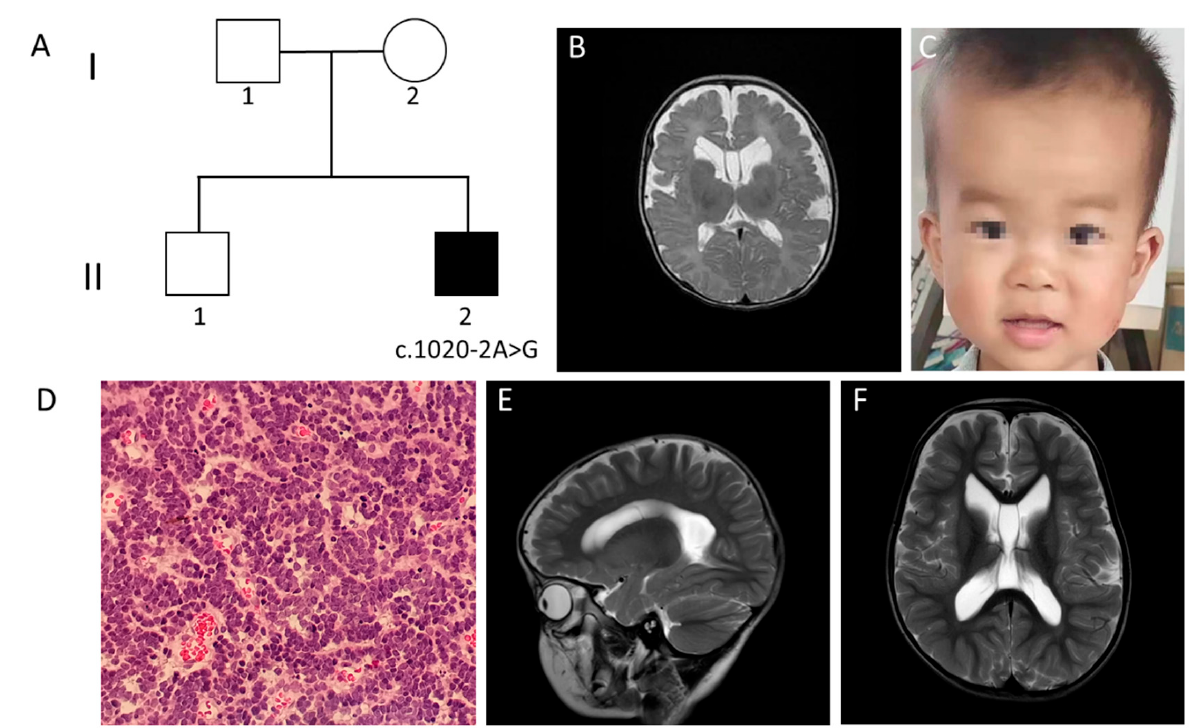
Figure 2. Clinical manifestations and auxiliary examinations of the case 2. ( A ) Family pedigree of case 2. ( B ) Brain MRI scans at 42 days demonstrated widened brain ventricle, deep brain sulci and subependymal cyst (axial plane, T2-weighted image). ( C ) Distinctive facial features were identified. These included protruding forehead, rounded palpebral fissures, large irises, depressed nasal root, full nasal tip and abnormal gums. ( D ) Hematoxylin and eosin staining of surgical resection demonstrating highly cellular tumor with round nuclei and little cytoplasmic differentiation (original magnification × 200). ( E , F ) Follow-up brain MRI scans at three years of age still demonstrated enlarged brain ventricle, deep brain sulci and subpendymal cyst (sagittal and axial plane, T2-weighted image).